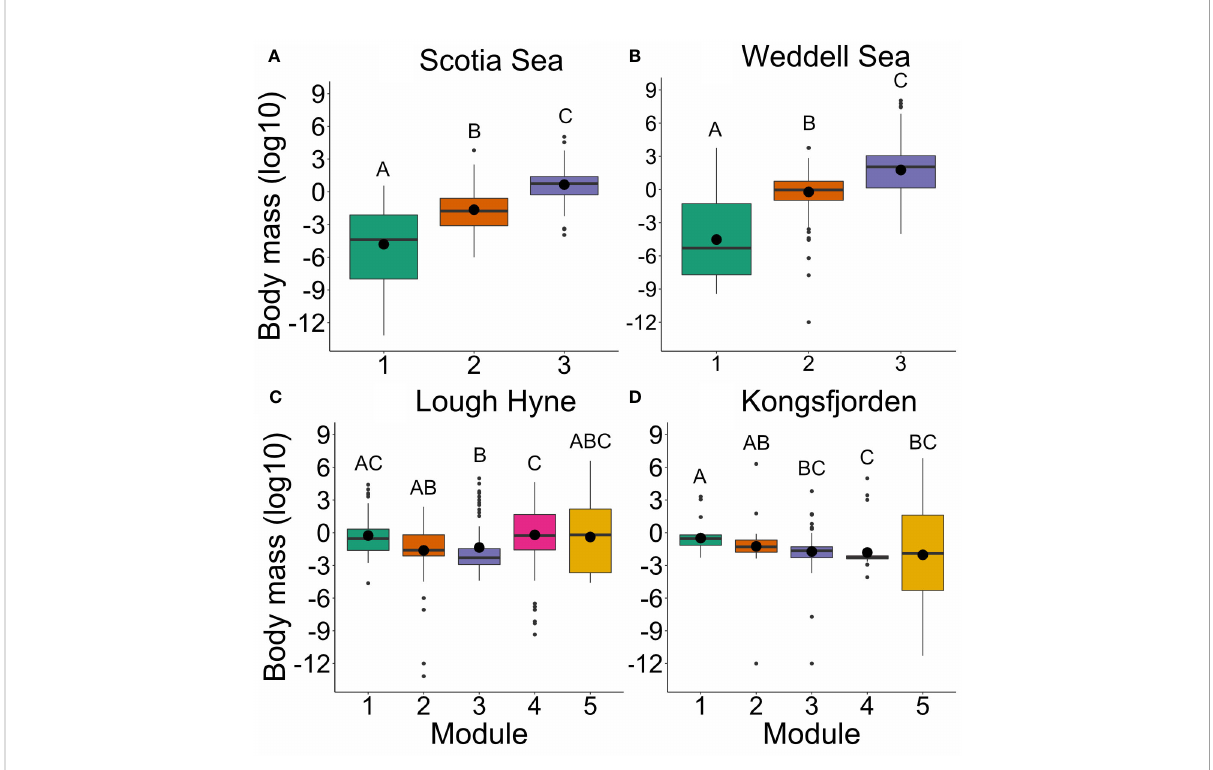
FIGURE 6 Boxplots of body mass across modules within each network: (A) Scotia Sea; (B) Weddell Sea; (C) Lough Hyne; (D) Kongsfjorden. Large black points indicate the mean, thick horizontal lines represent the median, boxes indicate the interquartile range, whiskers are 1.5 × the interquartile range, and outliers beyond this range are indicated as small black points. Boxes not sharing a common letter are signi fi cantly different from one another using a Dunn test ( p <